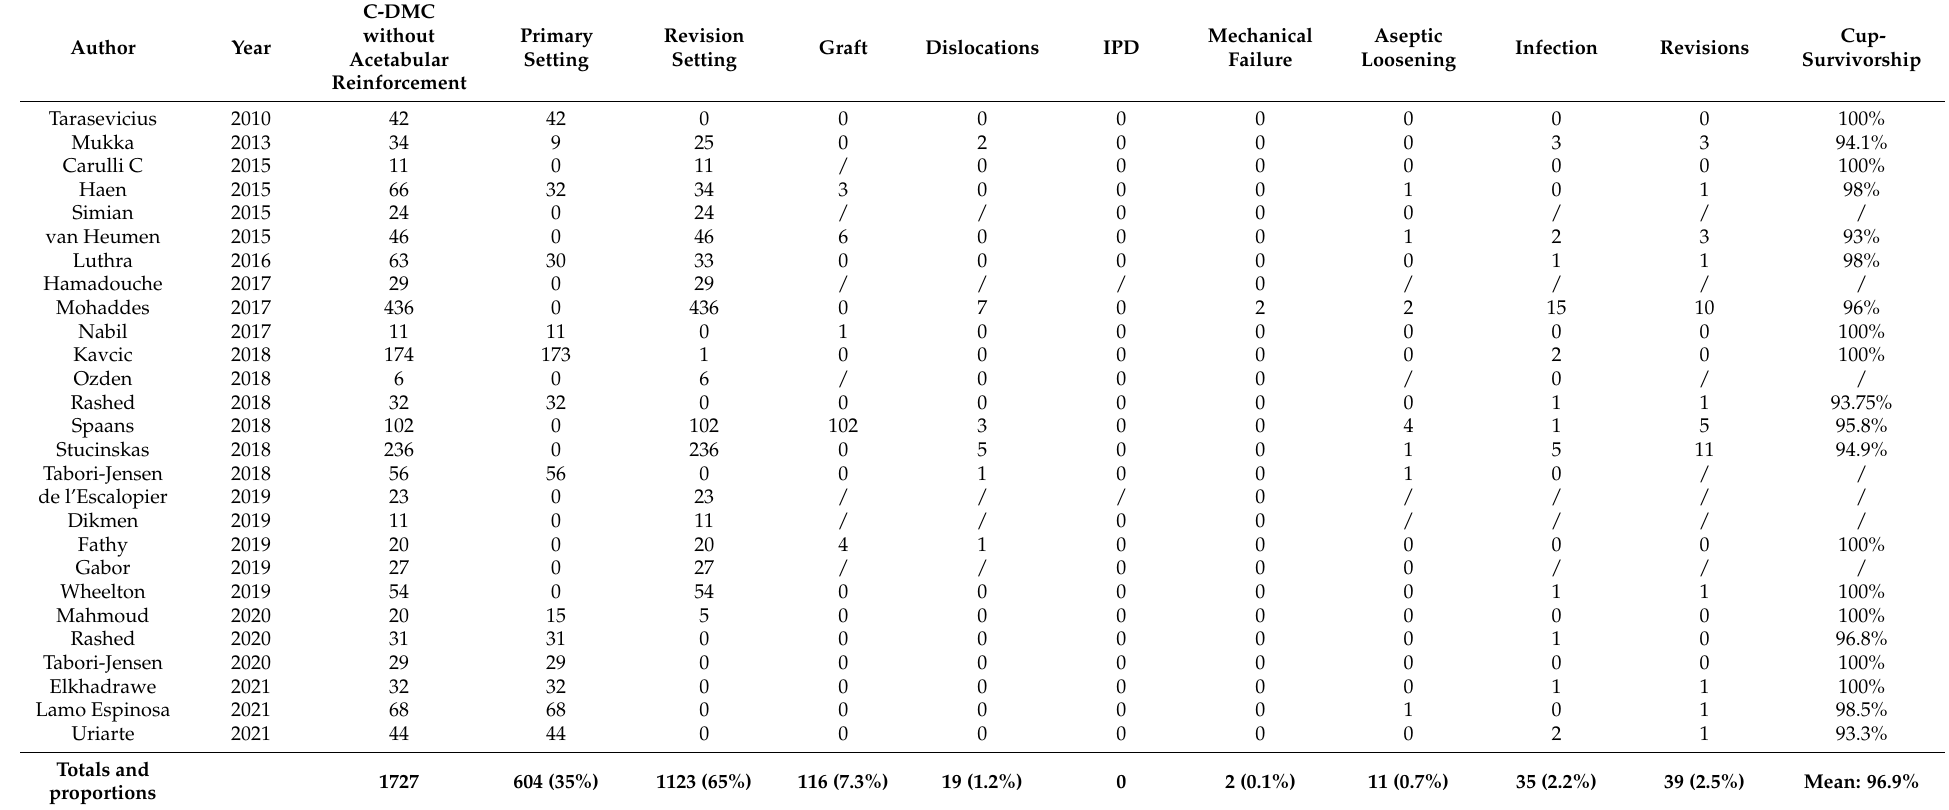
Table 8. Cemented DMC without acetabular reinforcement.